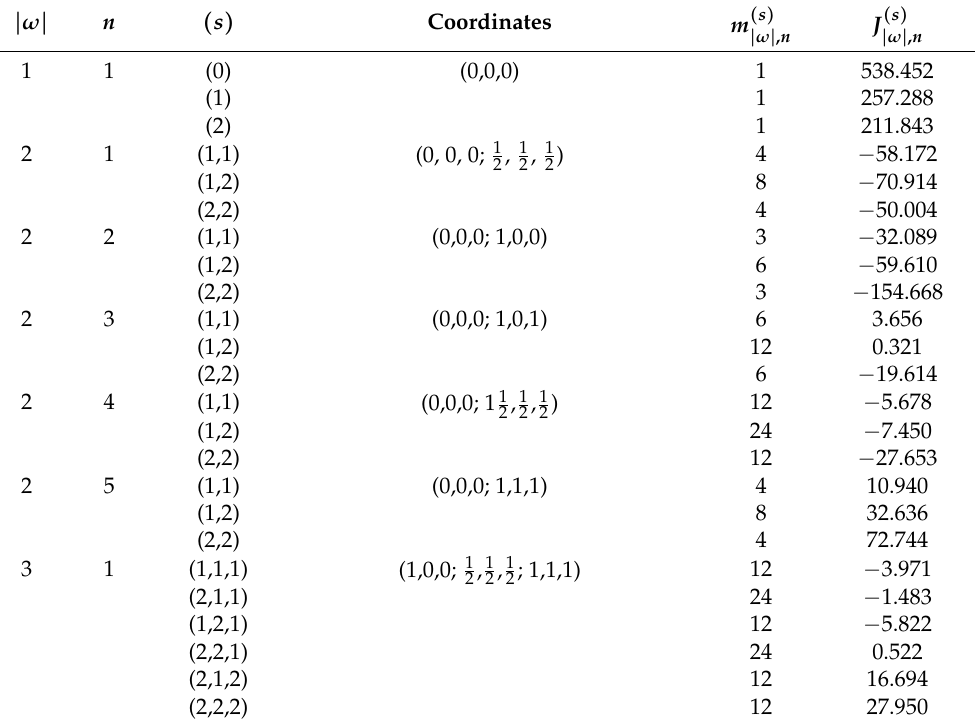
( s ) denotes multiplicities, and | ω | , n